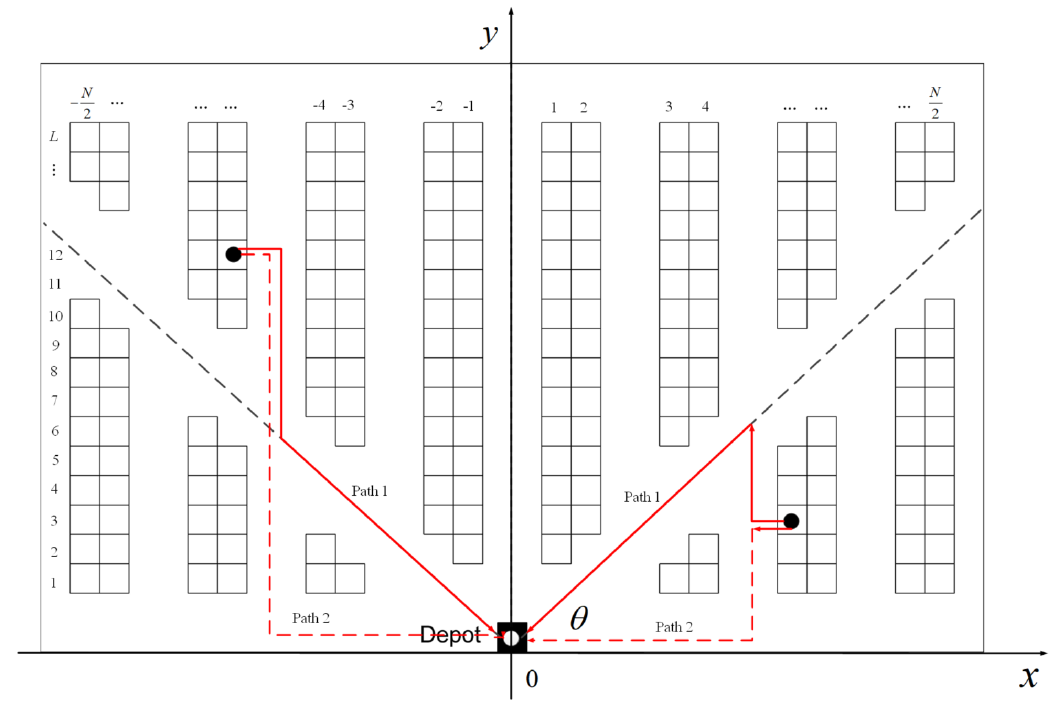
Figure 4. Sketch of a flying-V layout with single workstation.